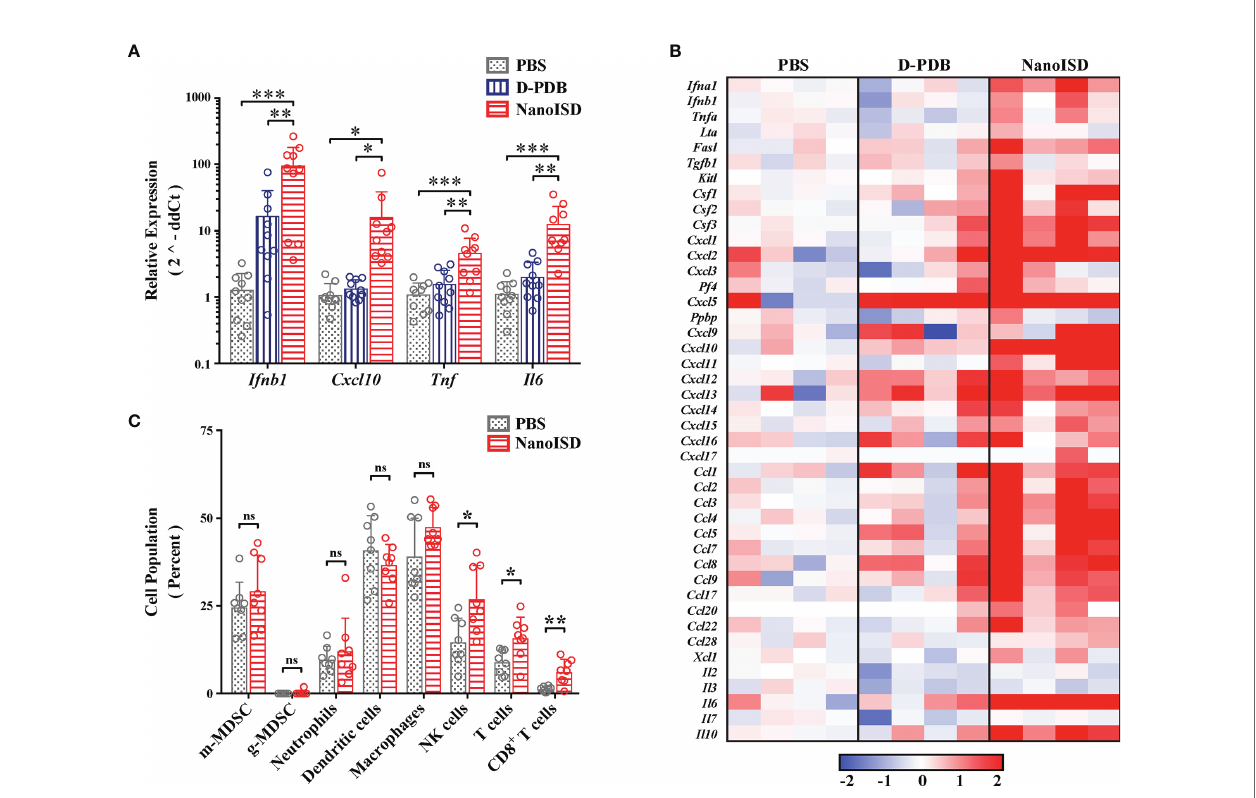
FIGURE 6 | NanoISD Reprograms the Immune Pro fi le of the Tumor Microenvironment. (A) Quantitative polymerase chain reaction (qPCR) analysis of B16.F10 tumors 6 hours following a single 100µL intratumoral treatment of either PBS, D-PDB, or NanoISD at a dose corresponding to 2 µg DNA. A one-way ANOVA with Tukey test was used for statistical analysis. (B) NanoString analysis of B16.F10 tumors 6 hours following a single 100µL intratumoral treatment of either PBS, D- PDB, or NanoISD at a dose corresponding to 2 µg DNA. Data is presented as log2 fold change relative to PBS treatment. (C) Flow cytometry analysis of the cellular composition of B16.F10 tumors treated intratumorally with 100 µL of either PBS or NanoISD at a dose corresponding to 2 µg DNA. Tumors were harvested 48 hours after the third intratumoral injection of a q3d dosing regimen. Data is presented as percent of CD45 + live cells. A two-way ANOVA with Sidak test was used for statistical analysis. ***p < 0.005, **p < 0.01, *p < 0.05. ns, not signi fi